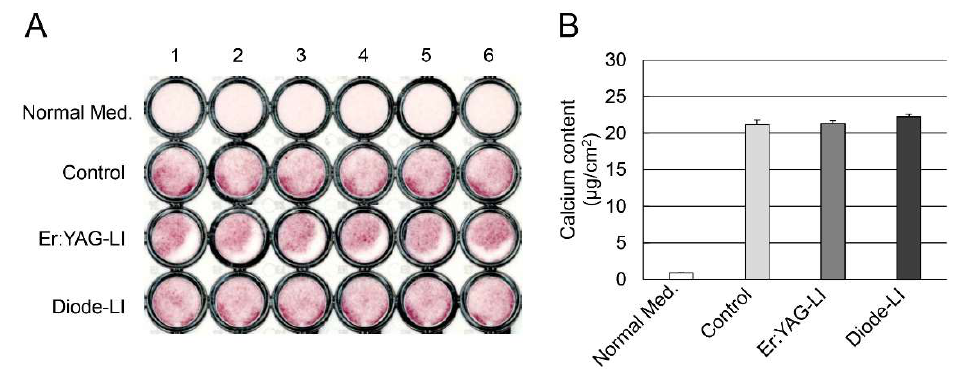
Figure 5. Effect of LI on mineralization nodule formation in PPU-7. ( A ) Nodule cultures with and without mineralization induction were stained with 1% Alizarin Red S on day 7. Nodule formation was apparent in PPU-7 after the two laser treatments (Er:YAG-LI and diode-LI), in contrast to cells not induced for mineralization (Normal Med.). Mineralization nodules in PPU-7 also formed under mineralization induction conditions without LI (Control). ( B ) The calcium content of PPU-7 was determined on day 7 after mineralization induction. Values are the means ± standard error of 6 culture wells.